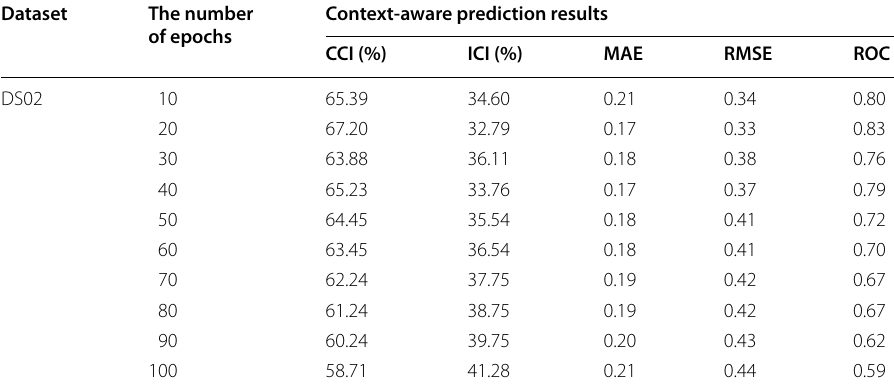
Table 4 Prediction results using neural network learning based context‑aware classification model utilizing dataset DS02